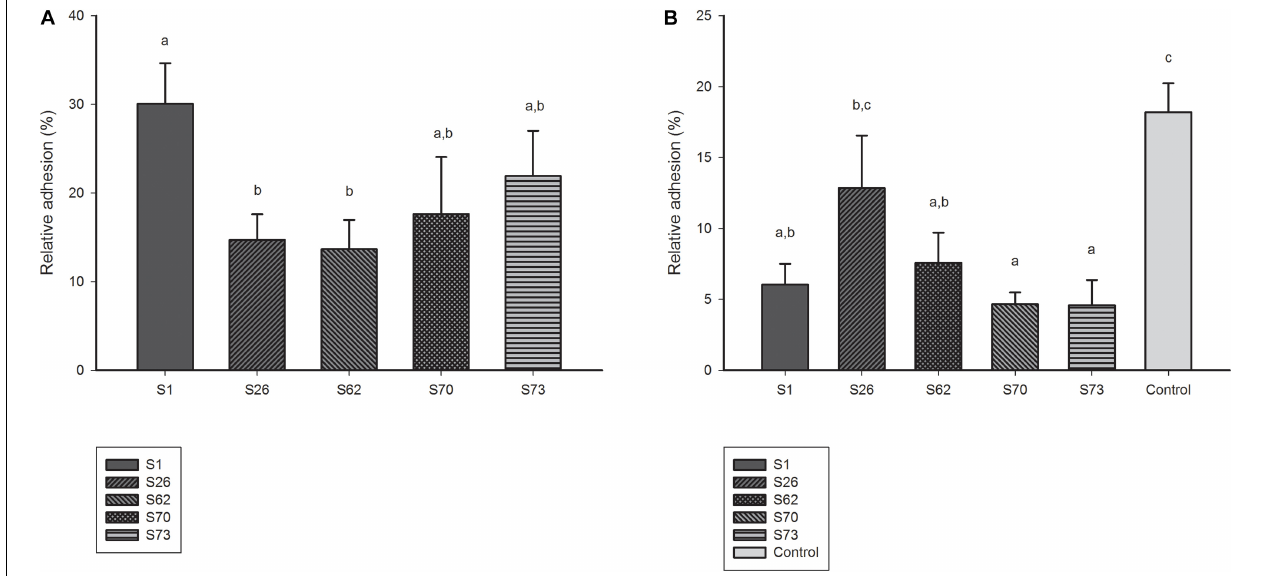
FIGURE 4 | (A) Adhesion ability of lactobacilli candidates to Caco-2 cell monolayers. (B) Adhesion ability of model E. coli strain co-incubated with lactobacilli candidates to Caco-2 cell monolayers.